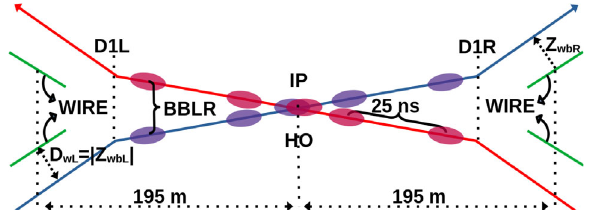
FIG. 1. Schematic representation (not to scale) for the head on collision, the beam beam long range kicks at the interaction regions and the reserved longitudinal position at the left and right of the IP1 and IP5 in the case of a future use of wire compensators in